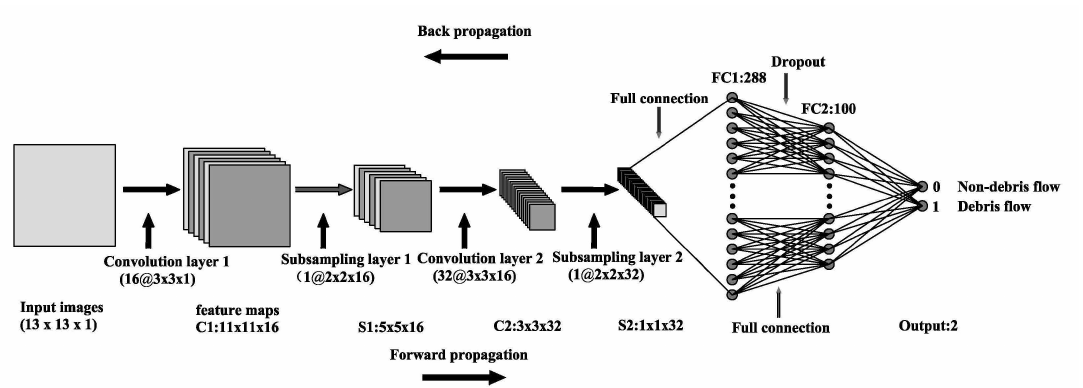
Figure 7. The VALID padding convolutional neural network (V–CNN) structure and the procedure of debris flow data processing.